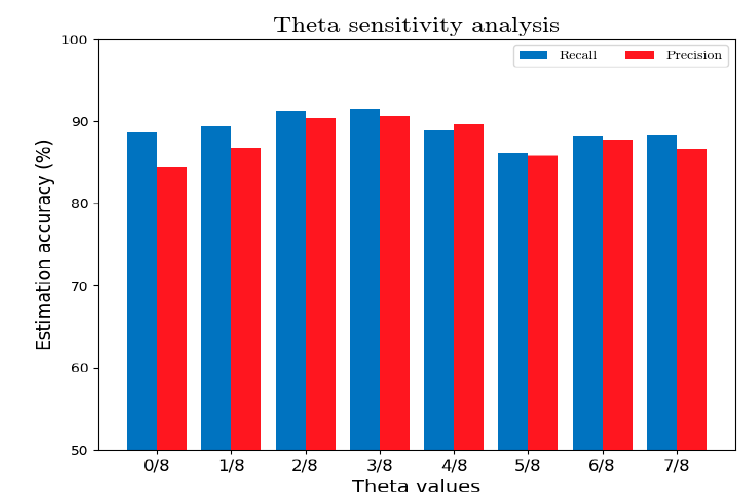
Figure 15. Effects of the θ -value on the fingerprinting performance.